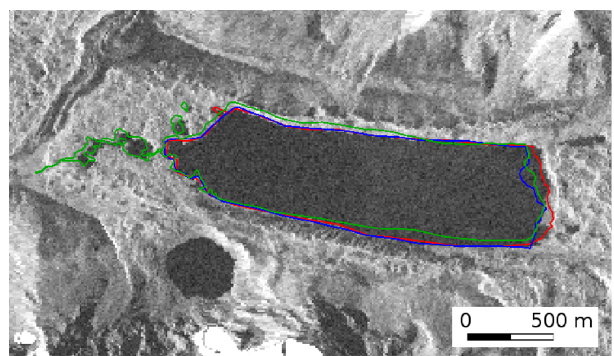
Fig. 10. Lakes outlines derived from TerraSAR-X data of April 2009 (blue) and October 2009 (red) and from field surveys (green) in May 2009 for Imja Tsho superimposed to the backscat- tering of the Radarsat-2 acquisition of May